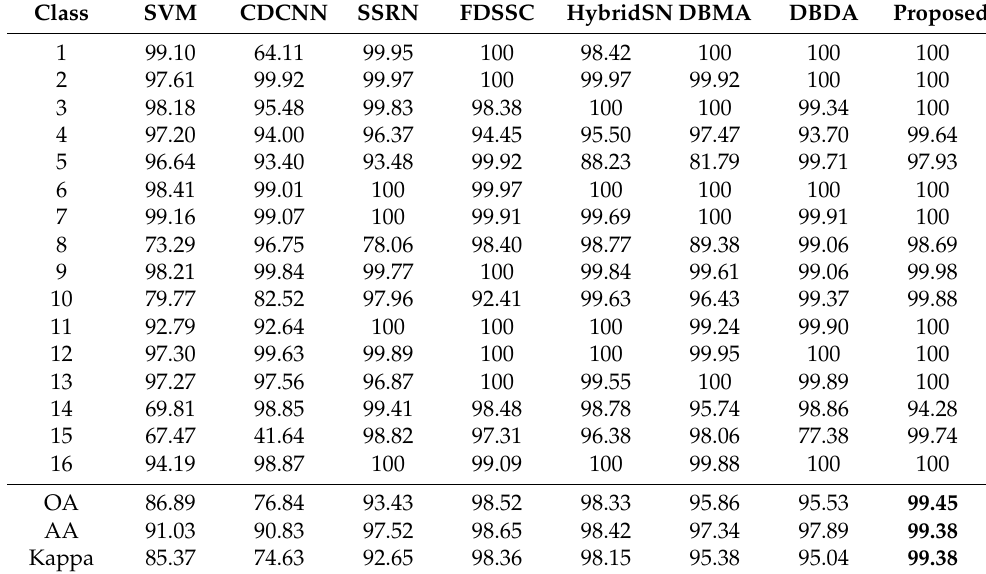
Table 10. The classification accuracy of different methods for the SA